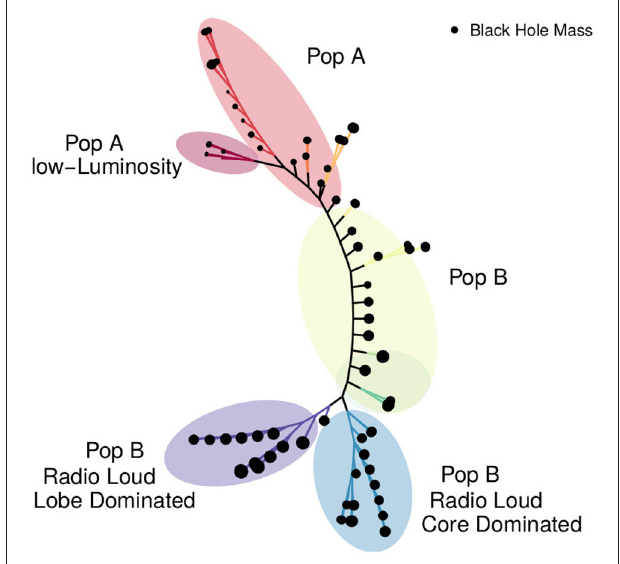
FIGURE 1 | The cladistics tree of 85 quasars. The tree representation is unrooted, but the low black hole masses (MBH) are at the top. We identify ten groups corresponding to bunches of branches and colored as in Figure 2 . The colored ellipsoidal regions indicates well-known categories of quasars and encompass several of our